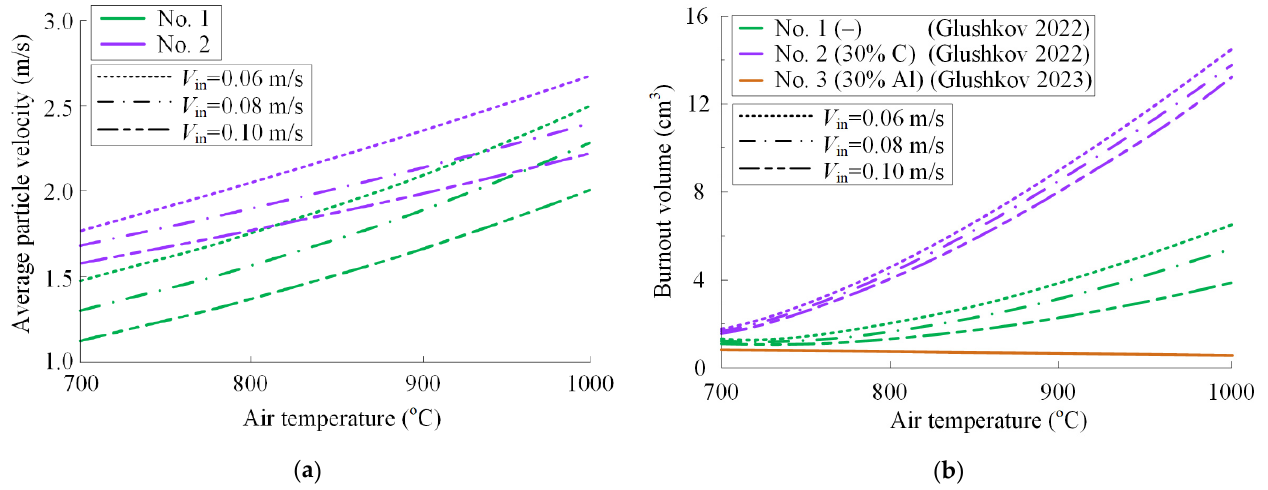
Figure 19. Characteristics of the dispersion of melts of gel fuels No. 1 and No. 2 at different rates of injection of fuel particles into the combustion chamber: ( a ) Speeds of movement of finely dispersed fragments during droplet dispersion [186]; ( b ) Dimensions of areas in which the process of burnout occurs [186,187].